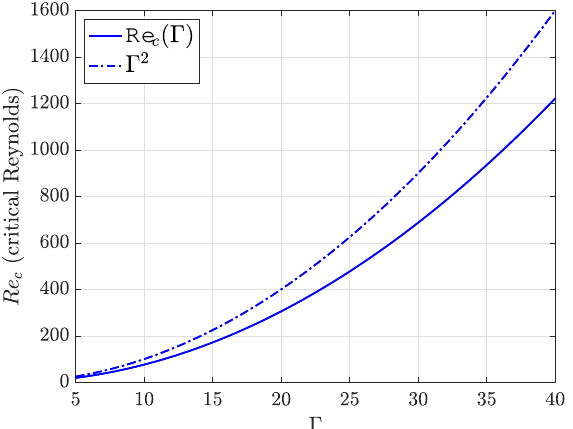
Figure 10. Critical Reynolds number vs. Γ : channel flow. Notice that the discrepancy between the Re c and the upper bound Γ 2 increases with Γ